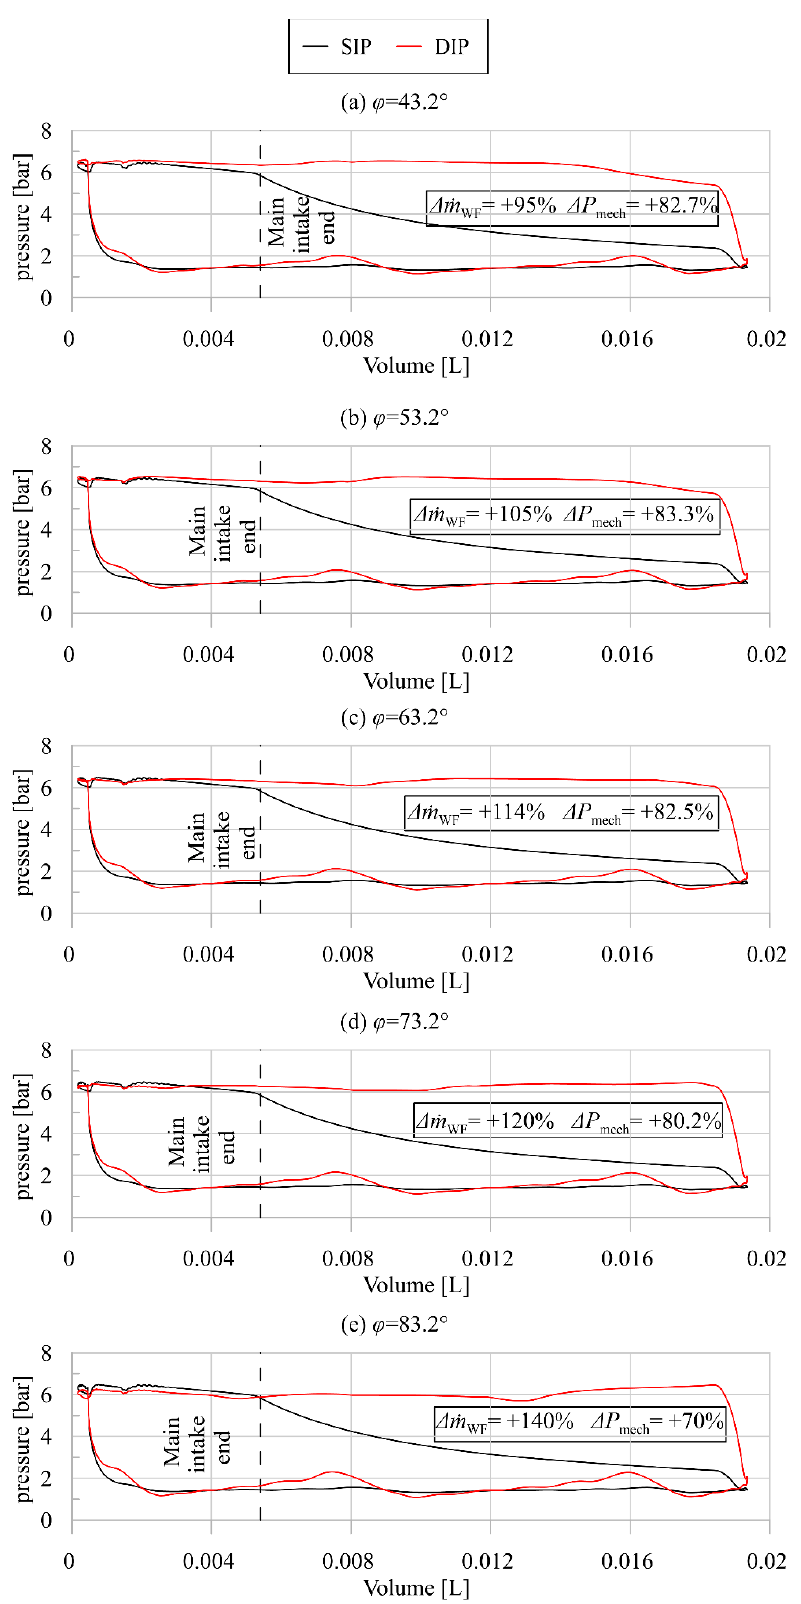
Figure 14. Comparison between the SIP and DIP SVRE indicated cycles when φ = 43.2° ( a ), φ = 53.2° ( b ), φ = 63.2° ( c ), φ = 73.2° ( d ) and φ = 83.2° ( e ).